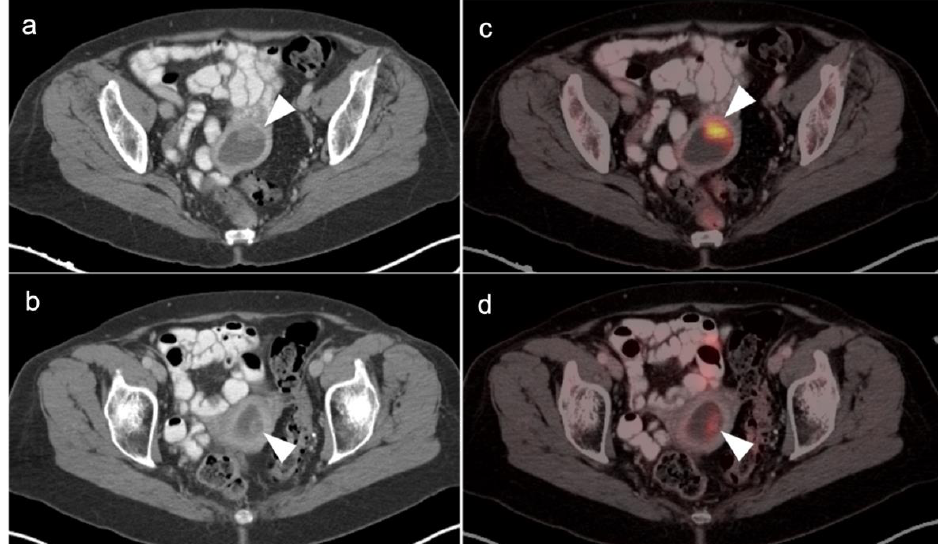
Figure 13. Endometrial polyp shown by axial FDG-PET_CT images of the pelvis in a 54-year-old woman with a long history of tamoxifen use for breast cancer. ( a , b ) Axial contrast enhanced CT of the pelvis shows a fluid-filled endometrial cavity containing a low-attenuating polypoid mass (white arrowheads). ( c , d ) Axial FDG PET-CT shows that the low attenuating polypoid lesion is intensely hypermetabolic (white arrow), a histologically proven to be benign hyperplasic polyp. A small endometrial carcinoma would have a similar appearance.